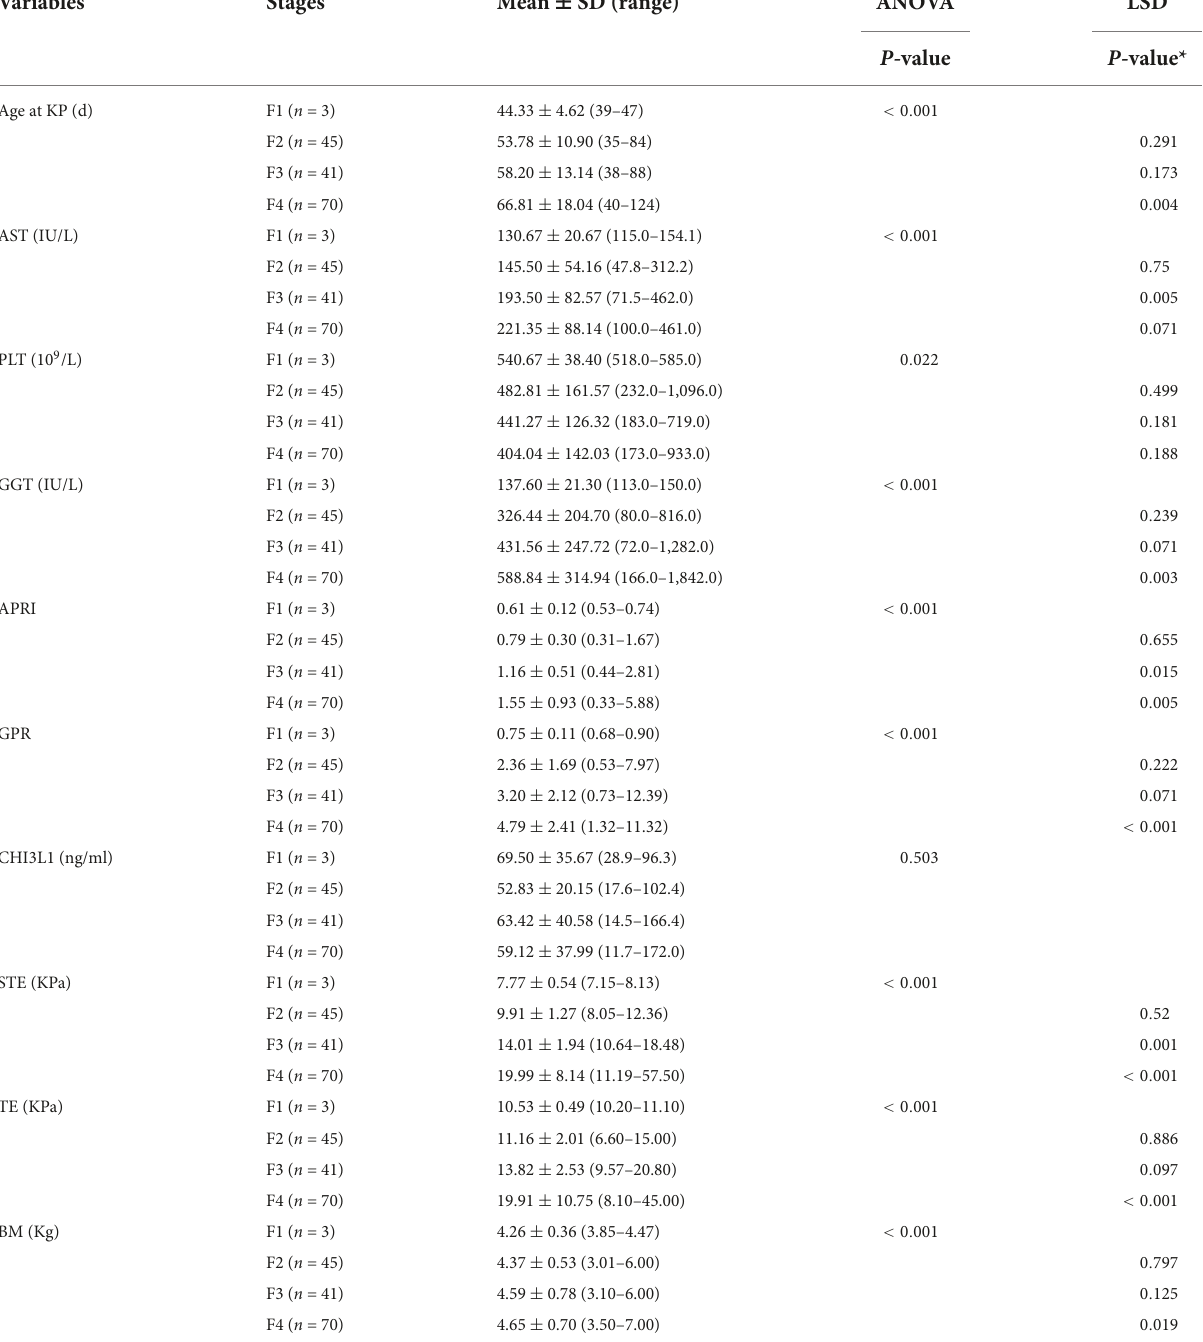
TABLE 1 Comparison of various parameters among different stages of hepatic